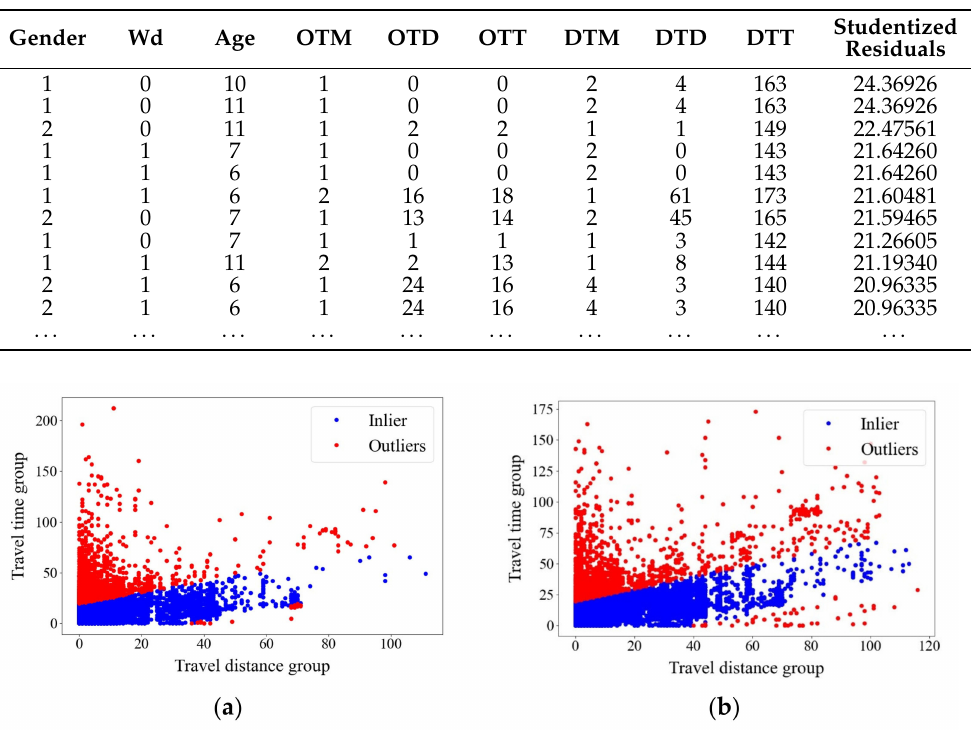
Figure 6. ( a ) Identification of abnormal value based on the variables of destination travel distance and time (May 2019); ( b ) Identification of abnormal value based on the variables of destination travel distance and time (May 2021).